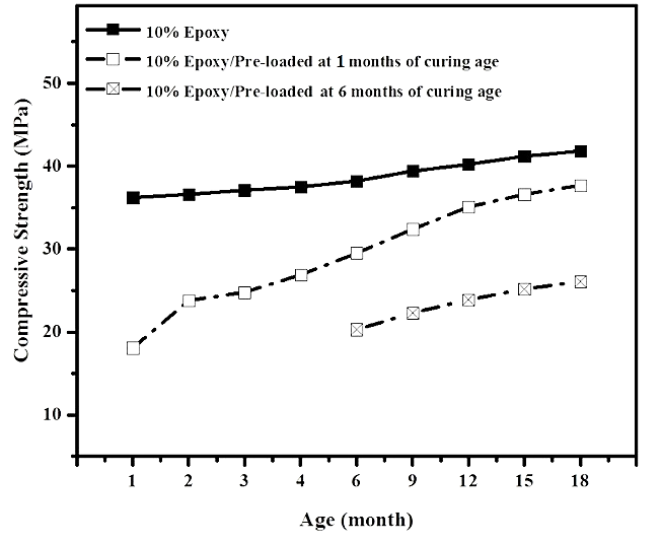
Figure 14. Effect of artificial cracks age on CS and healing efficiency development.